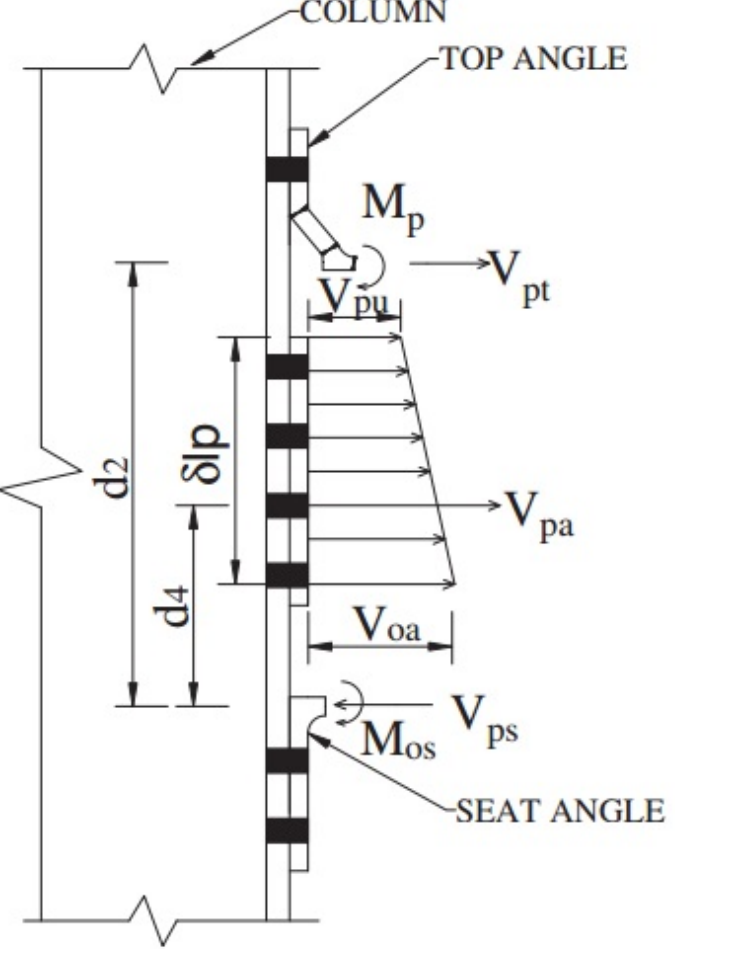
Figure 6. Collapse mechanism for TSACW. Reproduced from [14] with permission from Elsevier, copyright agreement with license number 5011231057466, February 2021.